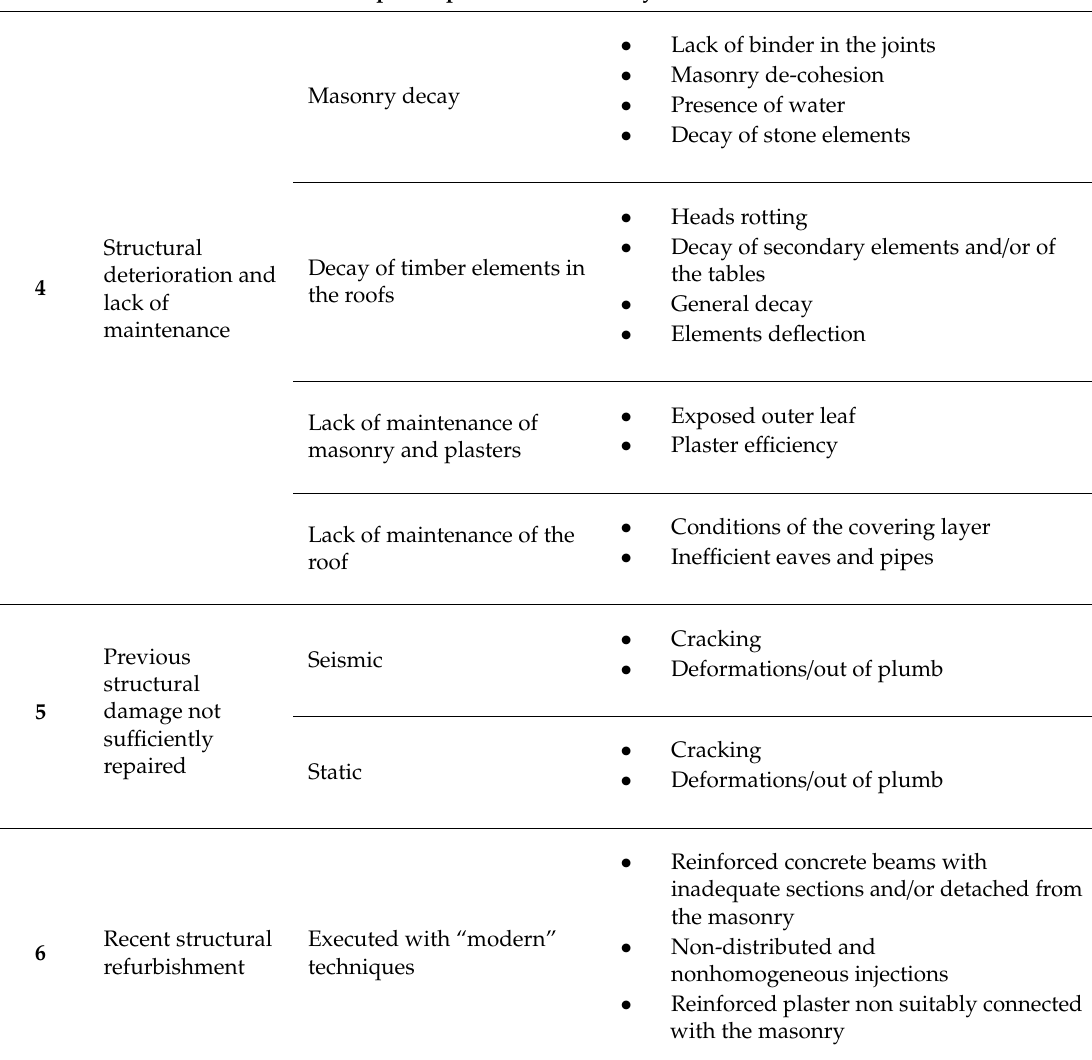
Thematic Groups of Specific Vulnerability Forms Attributed